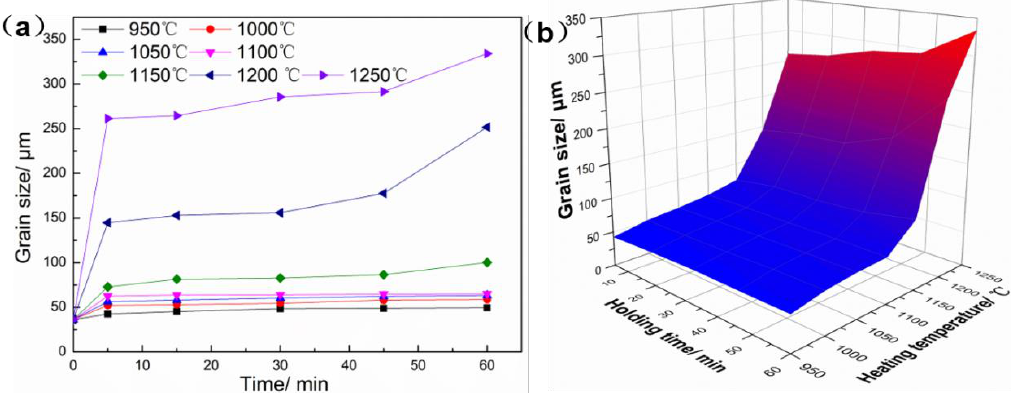
Figure 5. Variation diagram of grain size for the GH3625 at different heating temperatures and hold- ing times: ( a ) 2D curves, ( b ) 3D color map. holding times: ( a ) 2D curves, ( b ) 3D color